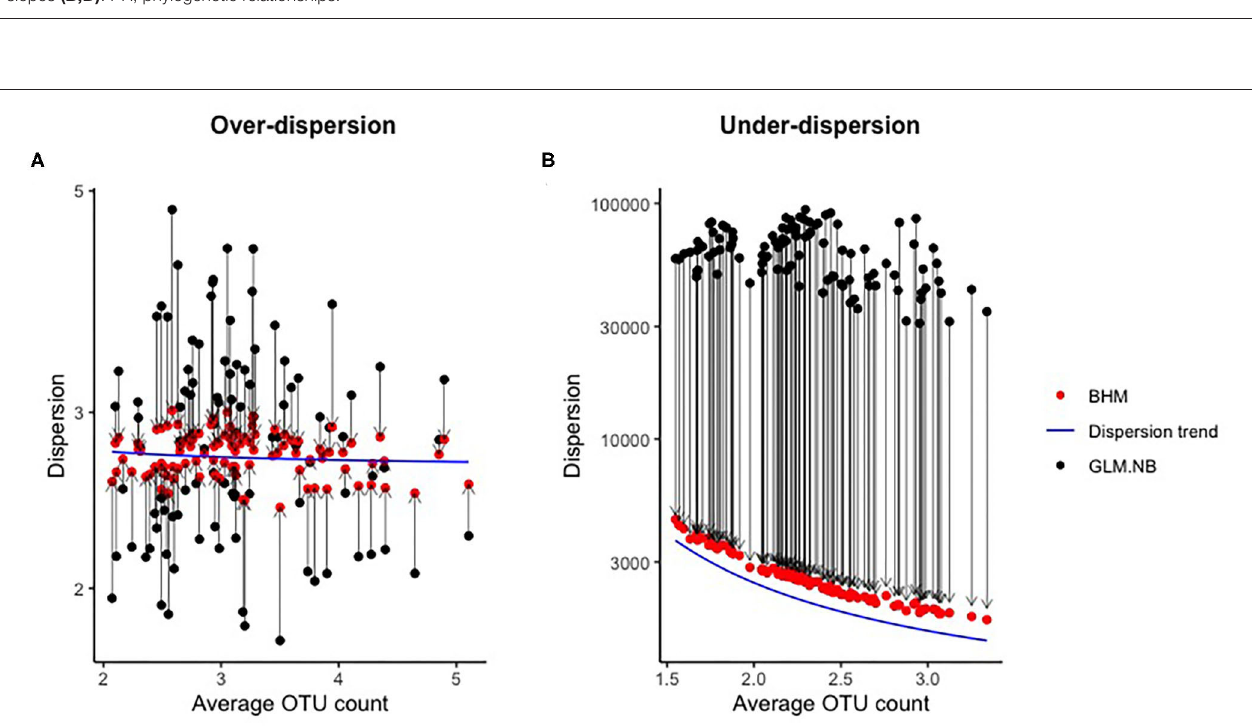
FIGURE 1 | The comparison between the true slope and the estimated slope of the simulation study; the mean squared error (MSE) (A,C) and bias between the slopes (B,D) . PR, phylogenetic relationships.